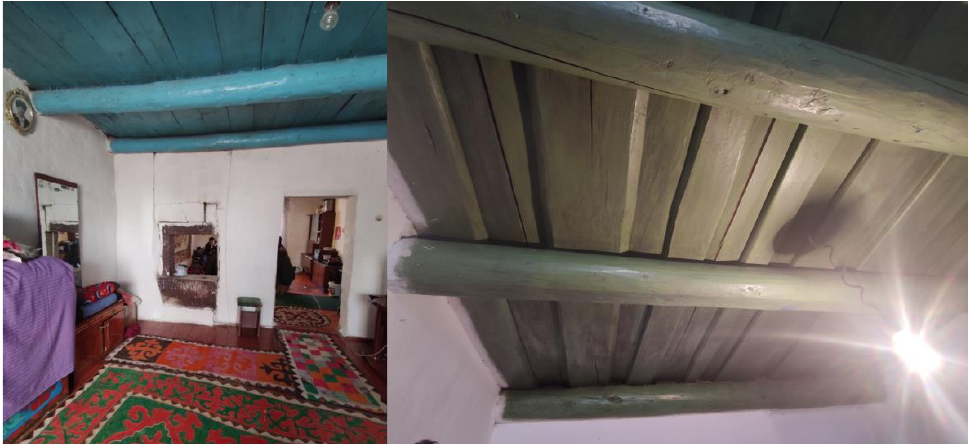
Figure 16. An example of a wooden-beam ceiling.